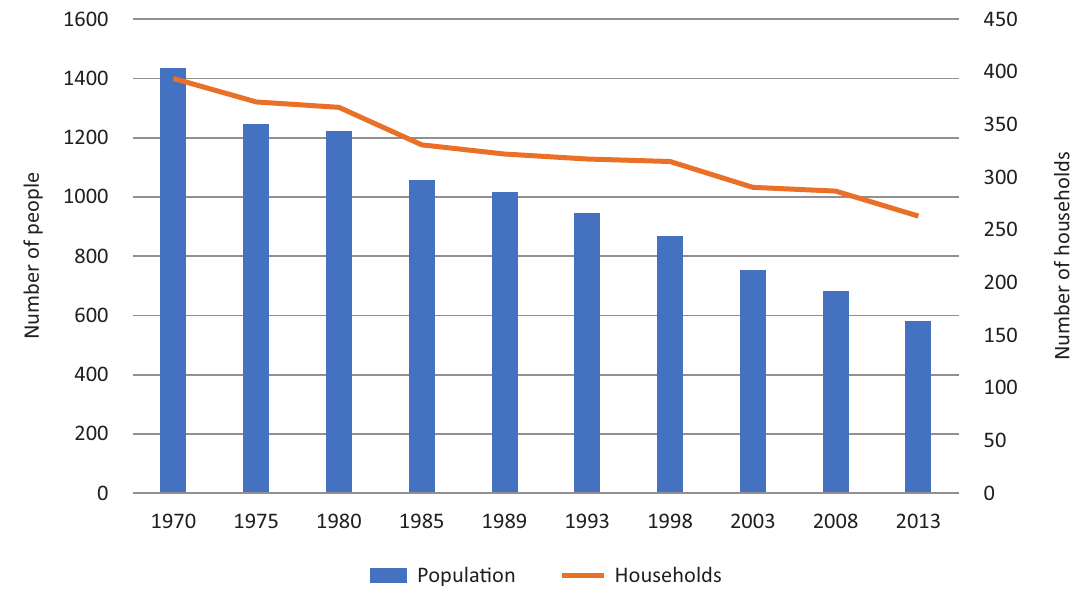
Figure 2. Population and number of households in Nijo, Masuda City. Source: Nijo Community Association